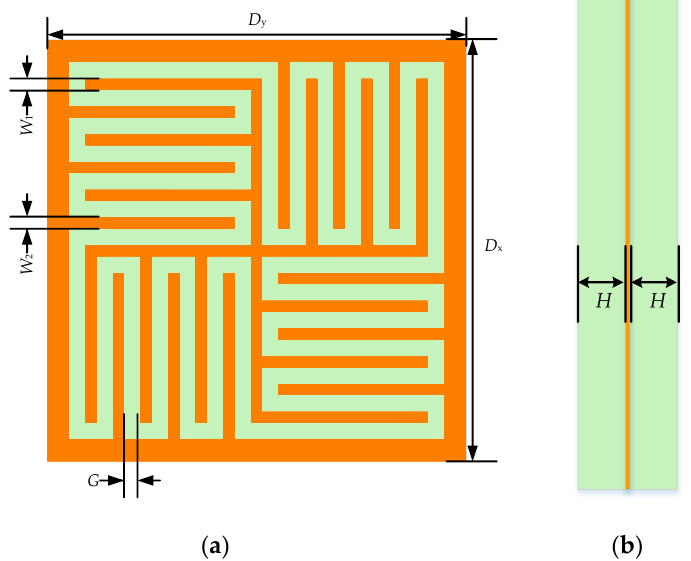
Figure 2. Diagrammatic sketch of the proposed unit: ( a ) top view; ( b ) side view.